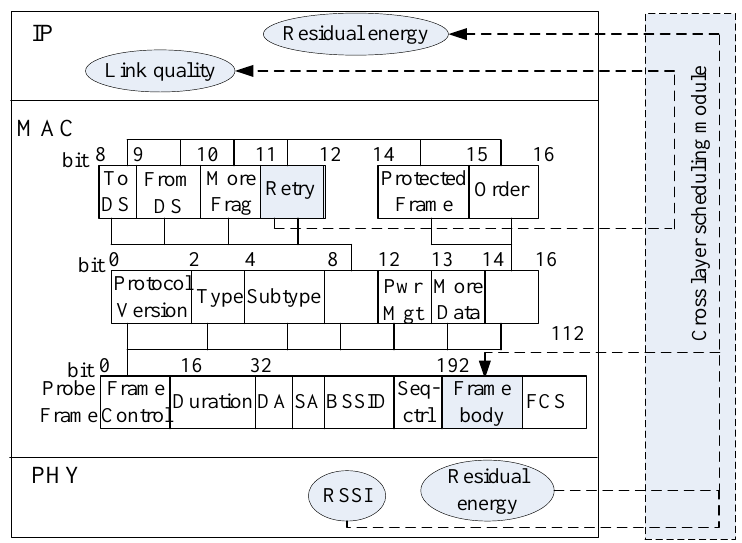
Figure 4. Schematic of information sharing via cross-layer.